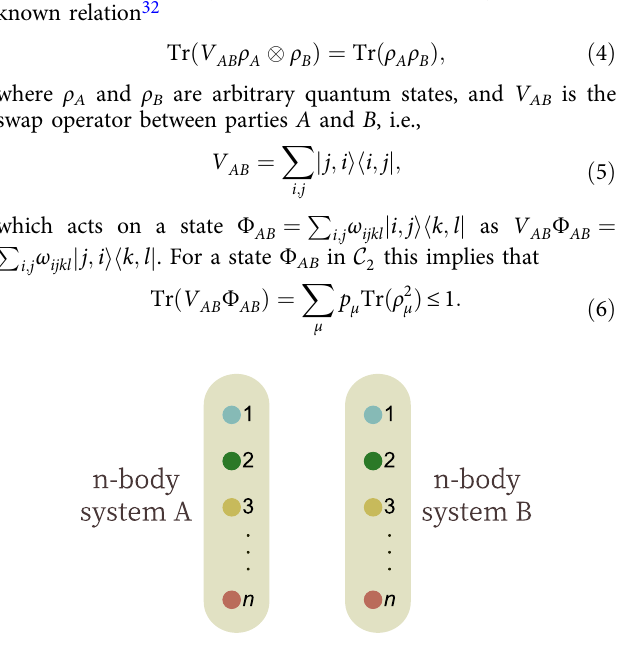
Fig. 1 Two-party extension for the marginal problem. In the